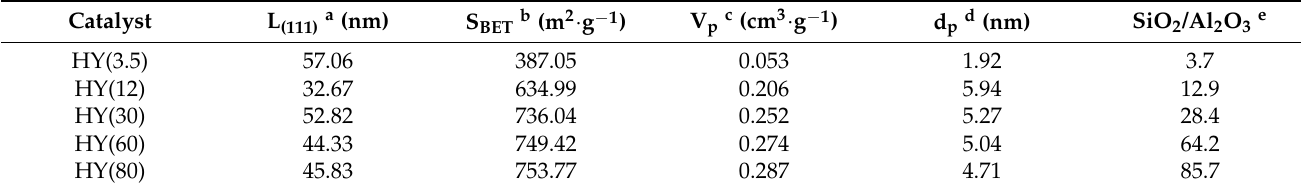
Table 1. Crystal size, textural properties and experimental SiO 2 /Al 2 O 3 molar ratios of the HY zeolites.